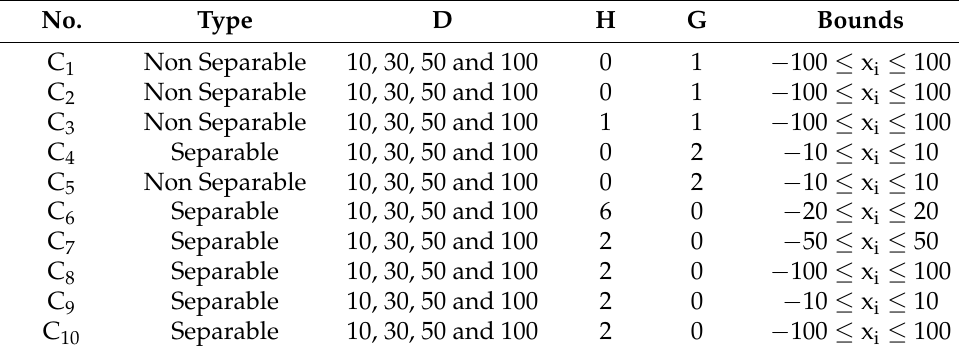
Table 2. Brief description of the Competitions on Evolutionary Computation (CEC) 2017 mathemati- cal constrained problems